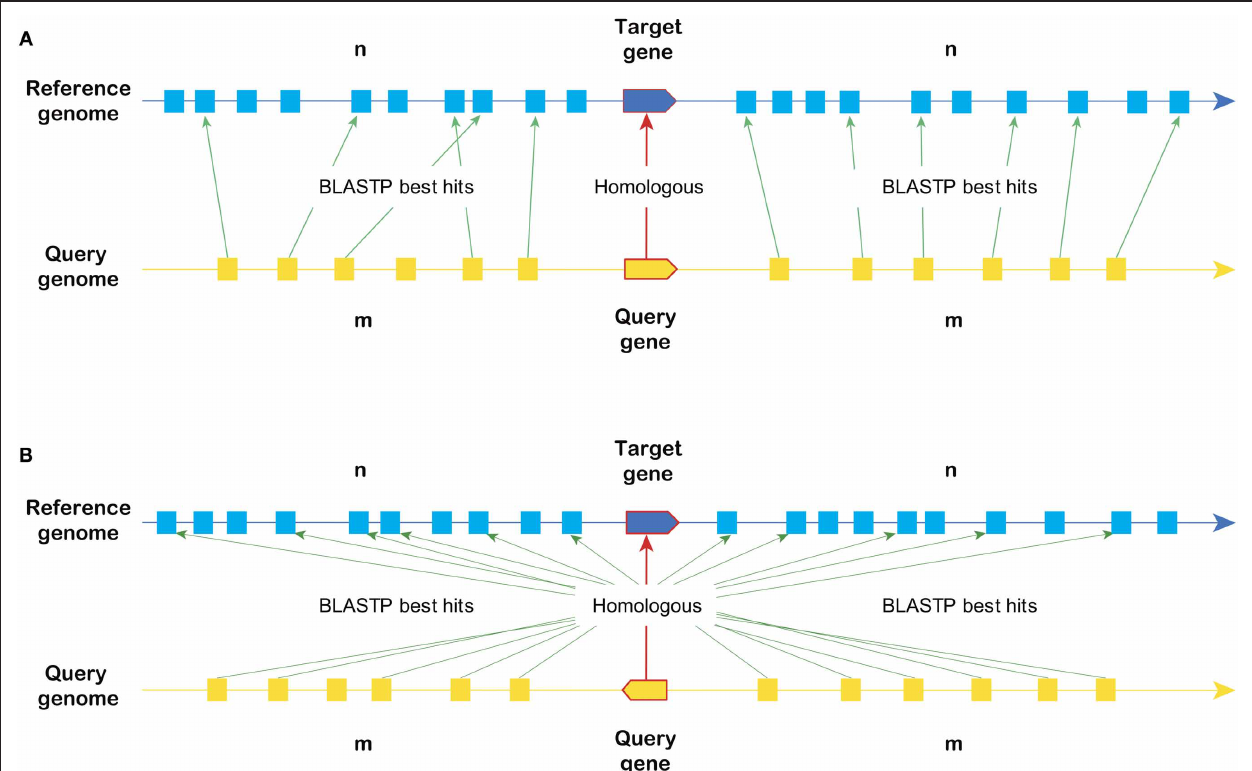
FIGURE 1 | The principles of syntenic gene identification in SynOrths. When determining whether two genes are under synteny, both the sequence homology of the two genes themselves and their flanking genes are considered. (A) Syntenic genes in the same direction in each genome. (B) Two syntenic genes located in inverted syntenic